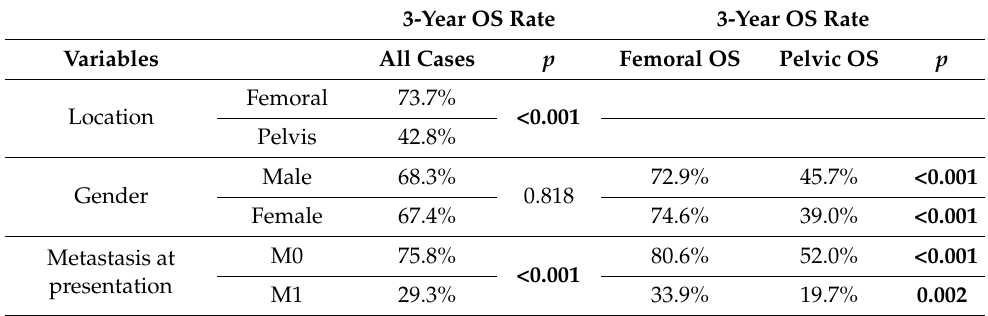
Table 2. Overall survival rate at 3 years in all cases, femoral osteosarcoma, and pelvic